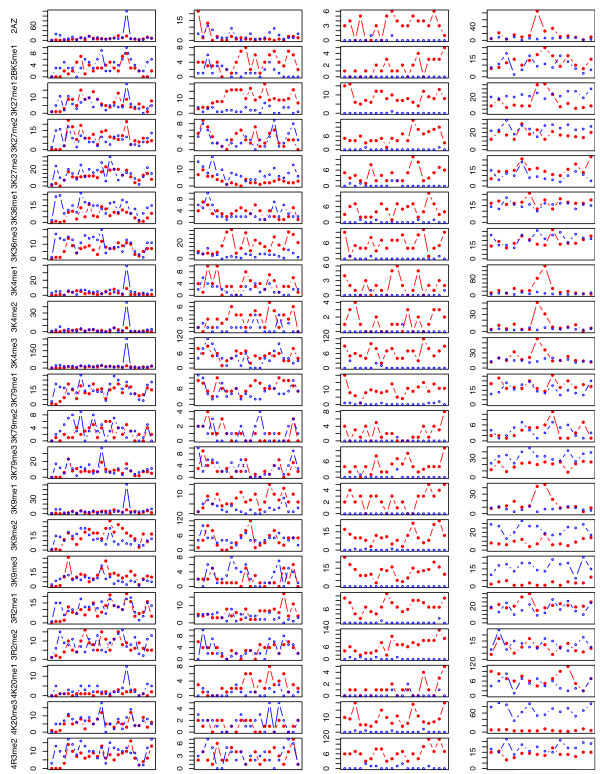
Pattern of histone modifications for the four SD pairs in Figure 3, ordered left to right to match their order from top to bottom in Figure 3. Each point represents the number of ChIP-Seq tags in a 5 kb genomic region, with red for parental and blue for derivative SDs. Horizontal axes are the position relative to the 5' end of a parental locus. Data for a derivative region is ordered with respect to its parent.